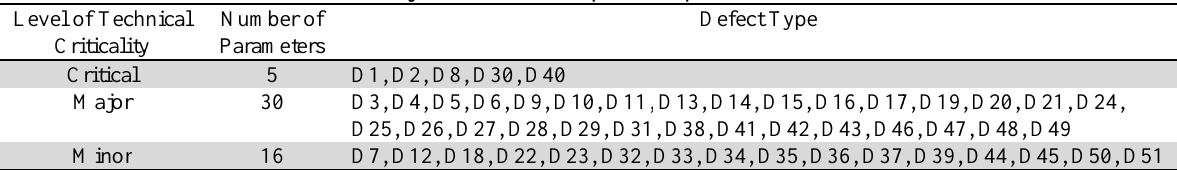
Classificatio Level of Tech